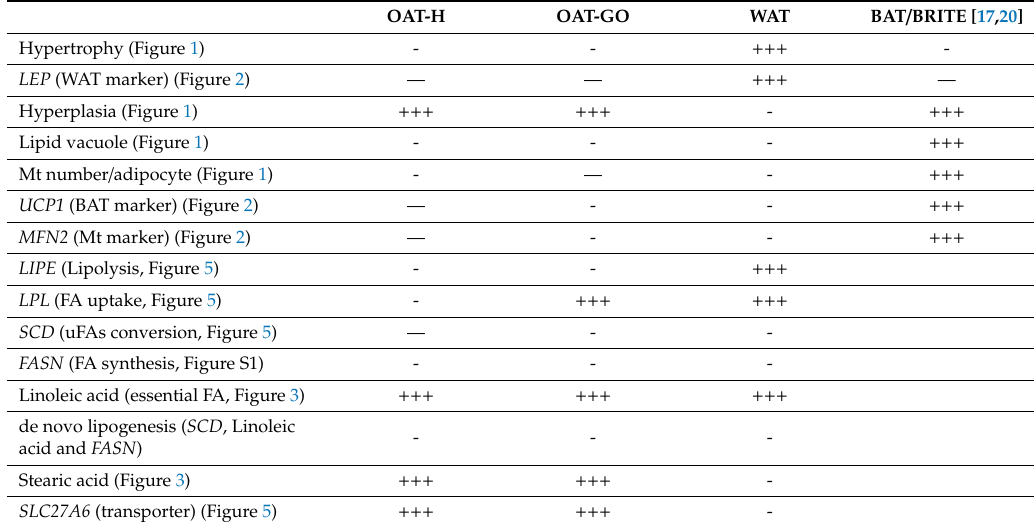
Table 2. Summary of key features of WAT and BAT / BRITE in OAT from this